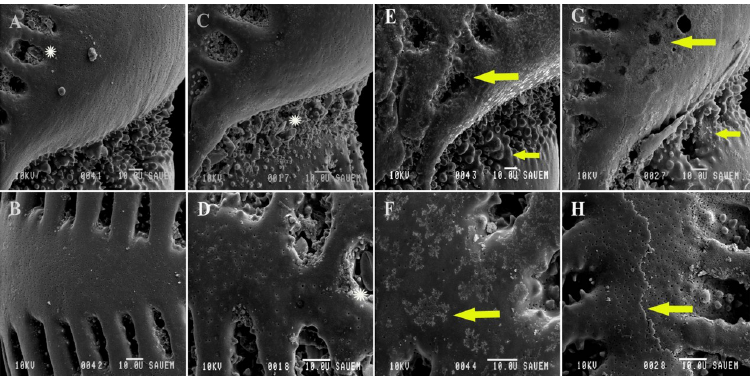
Fig 5. Scanning electron micrographs (SEM) images of live specimens of Elphidium williamsoni cultured at pH 8.1 (A & B), pH 7.9 (C & D), pH 7.7 (E & F) and pH 7.3 (G & H). (A) SEM image of side view of the apertural region showing numerous teeth and tubercles. A frustule of the diatom species Navicula sp . and organic material detritus are visible by a septal bridge. (B) Higher magnification of the test surface of specimen A. (C) SEM image of side view of apertural region, showing numerous teeth and tubercles with some impaled frustules of the diatom species Navicula sp . (D) Higher magnification of the smooth test surface of specimen C. (E) SEM image of side view of the apertural region, where signs of dissolution and cracking are clearly observed. Teeth and tubercles are less sharp with rounded shape. No frustules of diatom species are observed. (F) Higher magnification of the test surface of specimen E affected by dissolution and cracking processes. (G) SEM of side view of the apertural region showing a reduction in the number of teeth and tubercles. Dissolution and cracking processes are clearly observed in multiple structures with a severe effect on septal bridges and sutures. No frustules of diatom species are observed. (H) Higher magnification of the test surface of specimen G, showing several test wall layers, septal bridges and sutures affected by dissolution and cracking processes. ( � ) White asterisks show the presence of diatom Navicula sp . Yellow arrows show areas affected by